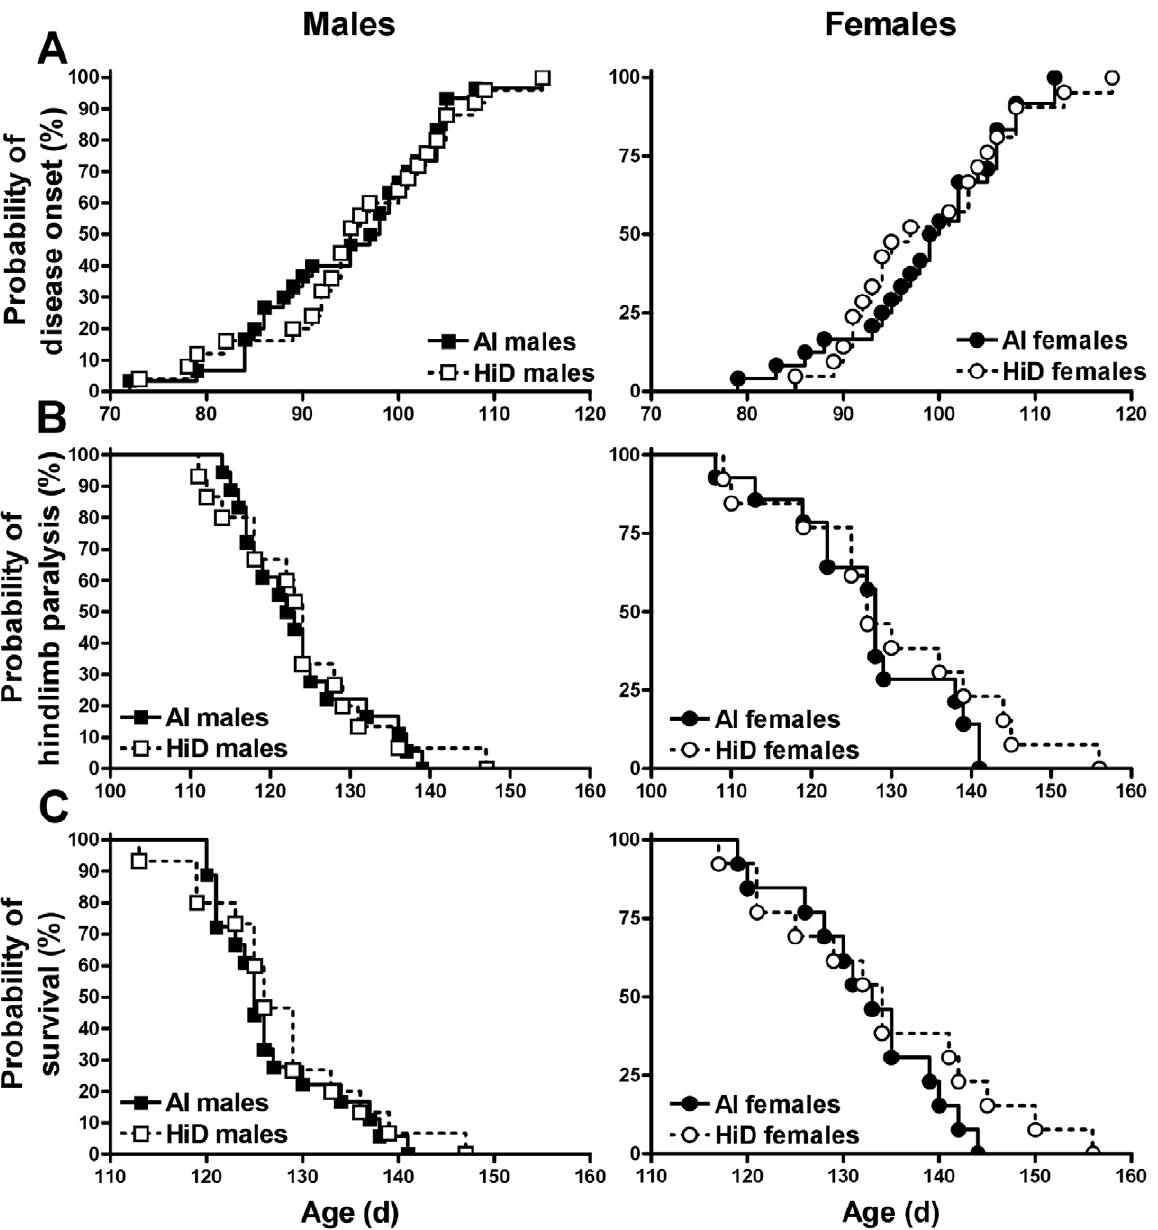
N Figure 3. Probability of disease onset (CS2), hindlimb paralysis (CS4) and survival (CS5). A) Probability of CS2 for 54 adequate intake (AI; N , 24 females) and 46 high (HiD; 50 IU D 3 /g feed; % , 25 males; # , 21 females) vitamin D 3 G93A mice. B and C) 1 IU D 3 /g feed; & , 30 males; , 13 females) and 28 high (HiD; 50 IU D 3 /g feed; % , 15 males; # , Probability of CS4 and CS5 for 31 adequate intake (AI; 1 IU D 3 /g feed; & , 18 males; 13 females) vitamin D 3 G93A mice. A) Males tended to reach CS2 at a 35% faster rate (i.e. the hazard ratio) vs. females (HR =1.35, 95% CI: 0.93, 2.14; P=0.055). AI males tended to reach CS2 at a 40% faster rate vs. AI females (HR =1.40, 95% CI: 0.83, 2.67; P=0.090), whereas there were no significant differences between HiD males and HiD females. B) Males reached CS4 at a 67% faster rate vs. females (HR =1.67, 95% CI: 1.05, 3.14; P=0.016). AI males had a 78% faster rate of reaching CS4 vs. AI females (HR =1.78, 95% CI: 0.9, 4.3; P=0.038). HiD males tended to reach CS4 at a 67% faster rate vs. HiD females (HR =1.67, 95% CI: 0.8, 4.0; P=0.075). C) Males reached CS5 at an 89% faster rate vs. females (HR =1.89, 95% CI: 1.22, 3.76; P=0.004). AI males had a 99% faster rate of reaching endpoint vs. AI females (HR =1.99, 95% CI: 1.05, 4.95; P=0.018), whereas HiD males had an 81% faster rate vs. HiD females (HR =1.81, 95% CI; 0.91, 4.75; P=0.042). doi:10.1371/journal.pone.0030243.g003 mainly driven by HiD females having a 20% greater AUC vs. AI had an 11% higher (P= 0.023) PaGE AUC corrected for CS AUC females (P= 0.020) (Figure S2C). During disease progression, vs. AI mice (Figure S4A). Prior to disease onset, HiD mice had a ATM and MP AUC negatively correlated with CS AUC for both 13% higher (P= 0.040) PaGE AUC corrected for CS AUC vs. AI mice. During disease progression, HiD mice had a 24% higher AI (P , 0.001; P = 0.035) and HiD (P , 0.001; P =0.087) mice, respectively (Figure S3A and S3B). Between 60 d-CS5, HiD mice PLOS ONE |